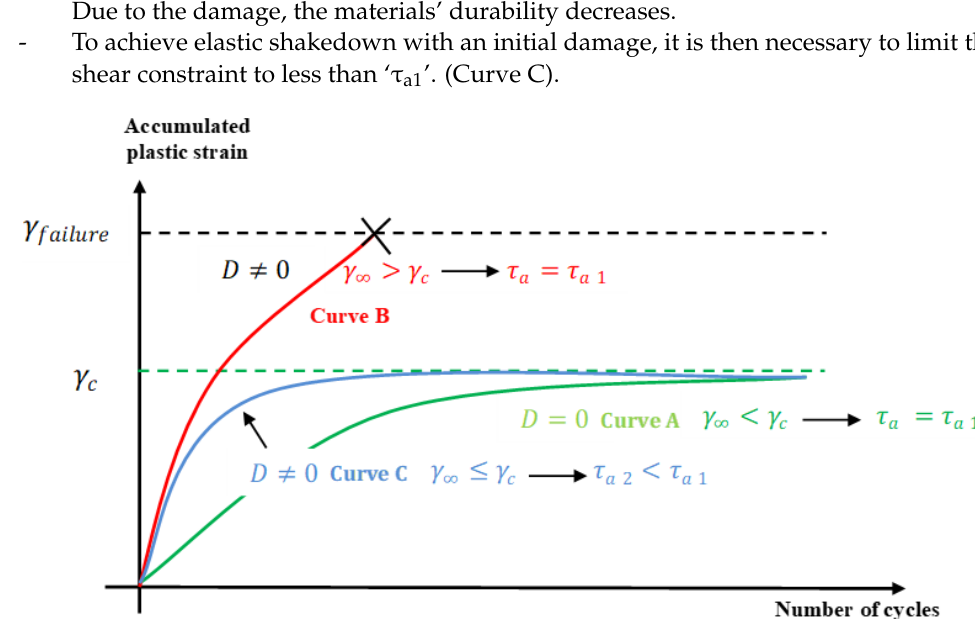
Figure 2. Cyclic behavior of a crystal with and without damage.